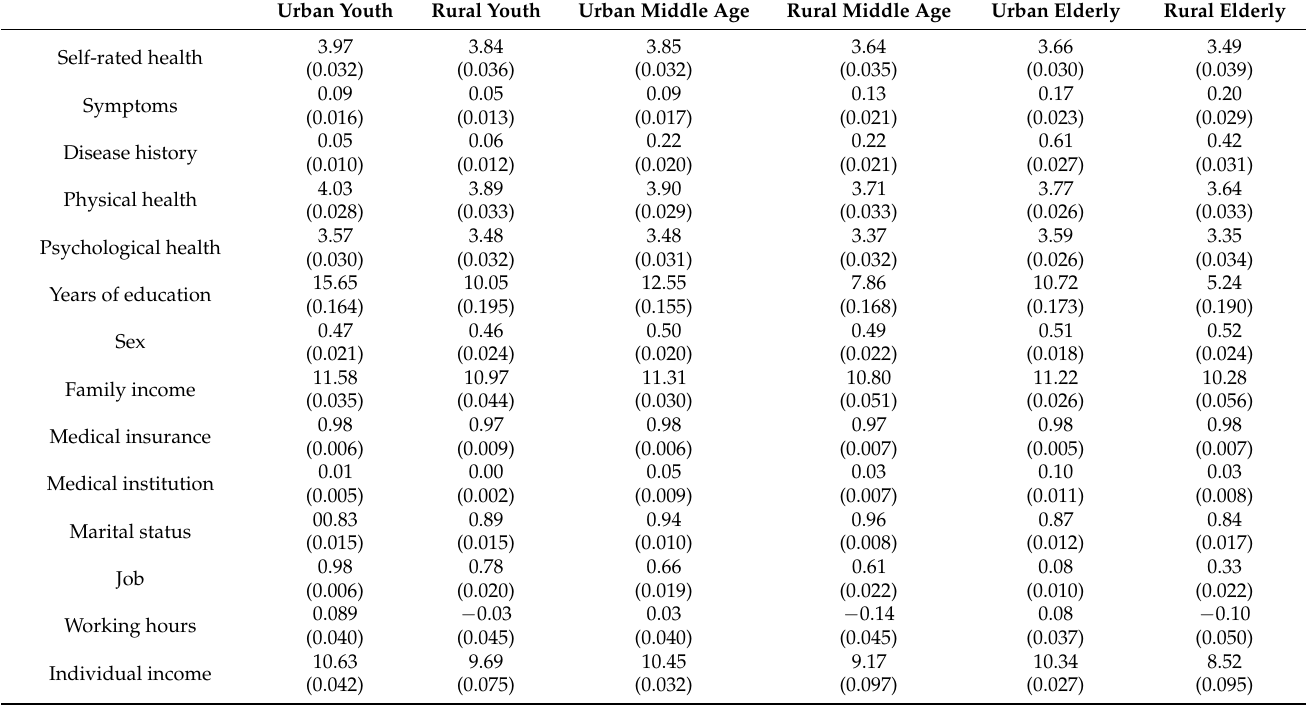
Table A3. Summary statistics of physical and psychological health (by age and